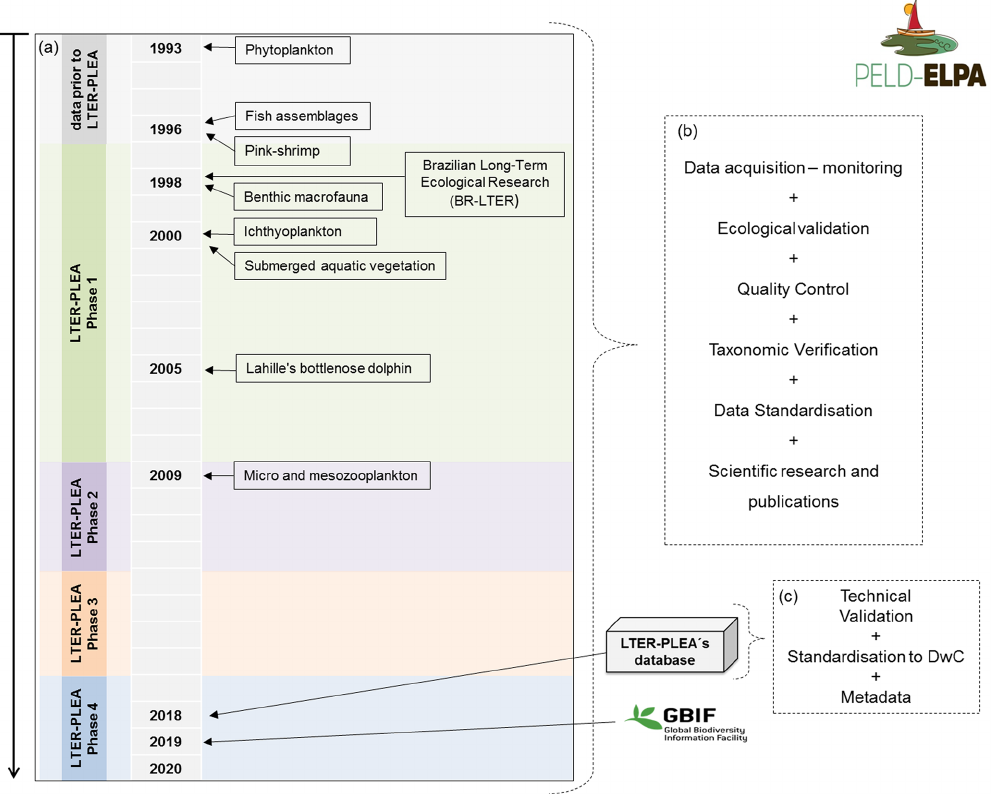
Figure 2. Stages of the LTER-PLEA’s database life cycle: from data collection to integration in the Global Biodiversity Information Facility (GBIF). (a) LTER-PLEA timeline; (b) quality assurance and control process; (c) technical validation process, formatting, and registration of the LTER-PLEA’s database in the GBIF. Table 2. Temporal coverage of the LTER-PLEA’s datasets.